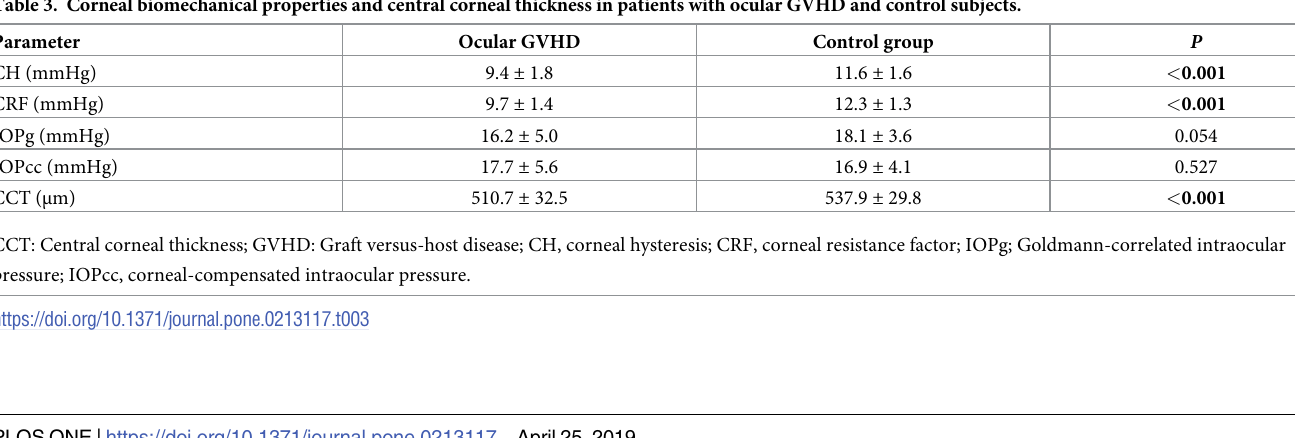
Table 3. Corneal biomechanical properties and central corneal thickness in patients with ocular GVHD and control subjects. Parameter